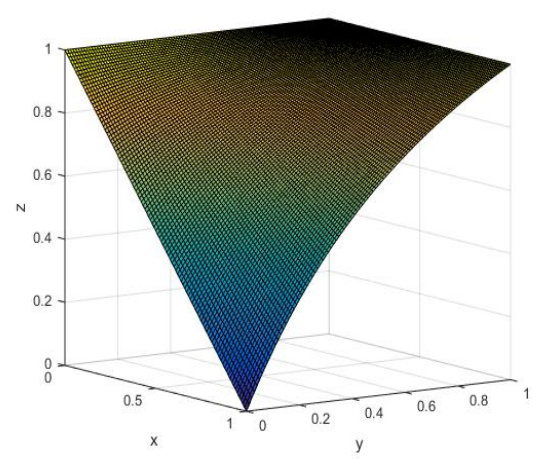
Figure 3. I implication of example 4.